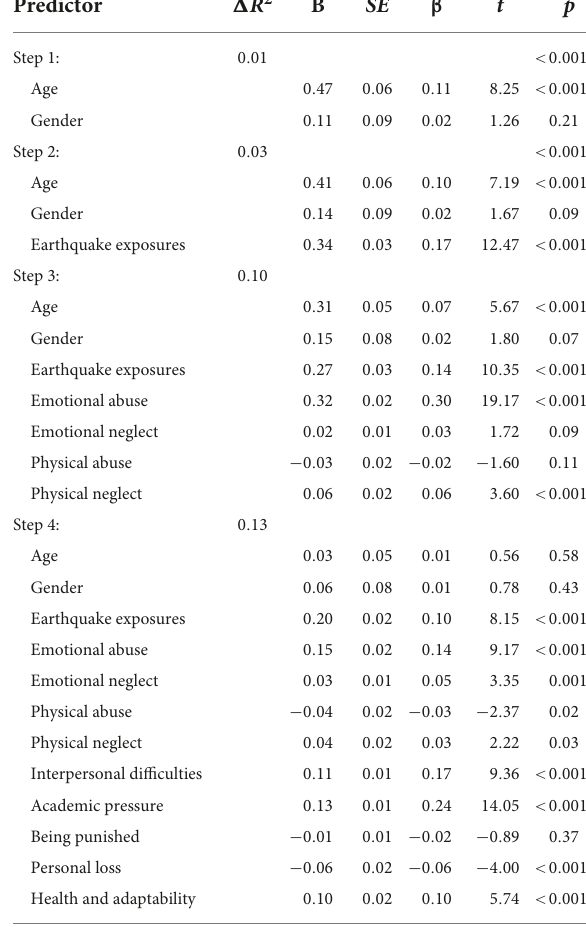
TABLE 2 PTSD and depression in adolescents experiencing multiple difficulties ( n = 5,195) stratified by age and gender. Variable